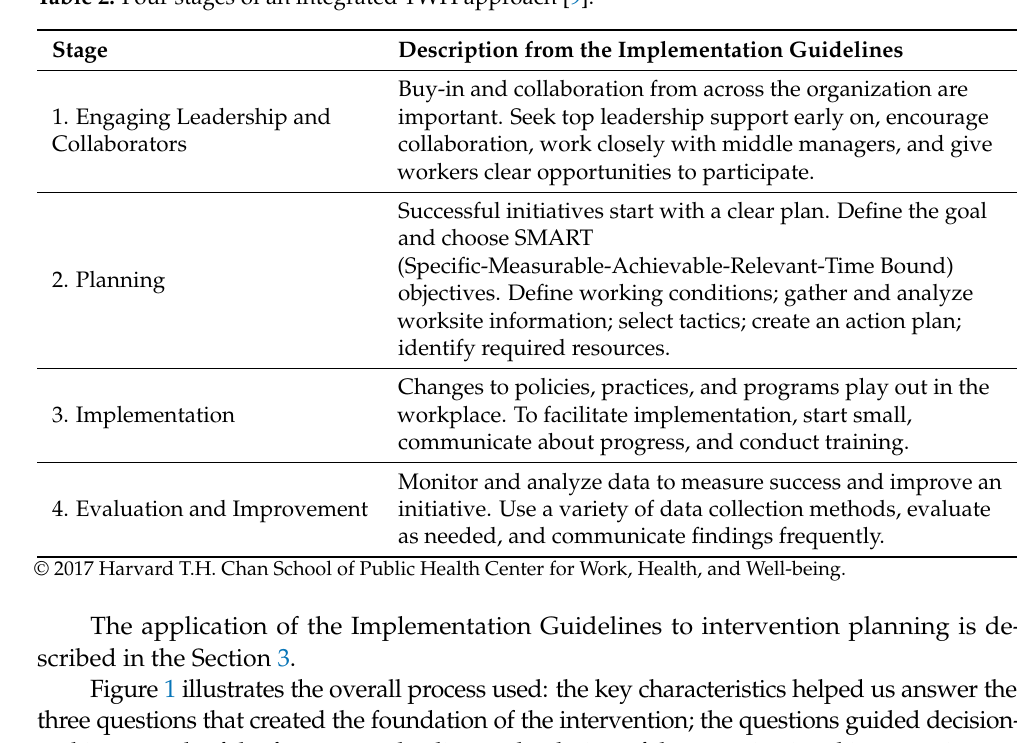
Table 2. Four stages of an integrated TWH approach [9].